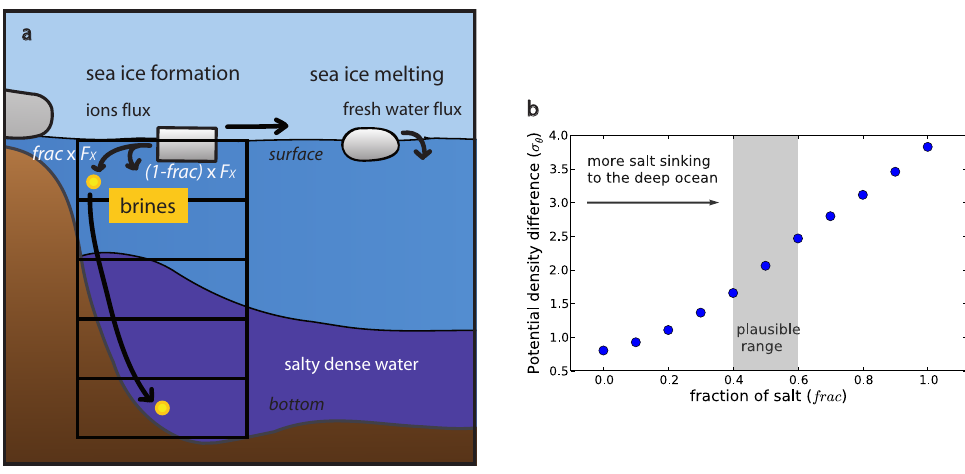
Fig. 1. (a) Brine sinking mechanism scheme and (b) Potential density difference between the deep Atlantic ocean (between − 5000m and − 3000m) and the upper Atlantic ocean (between − 2000m and 0m) as a function of the fraction of salt released by sea ice formation used for the brine mechanism (fraction of salt frac , 0 ≤ frac ≤ 1). (a) When sea ice is formed salt and other modeled ions (and dissolved gases), such as dissolved inorganic matter (DIC), alkalinity (ALK), dissolved organic carbon (DOC), nutrients, oxygen, DI 13 C and DI 14 C are released into the surface ocean beneath as a flux ( F X which is the flux of variable X ). A fraction of this flux ( frac · F X ) is dedicated to the brine sinking mechanism and is directly transported to the deep ocean instead of being diluted in the surface cell as the rest of the flux ( ( 1 − frac ) · F X ). This mechanism both creates a link from the surface to the deep ocean and sets an efficient deep ocean stratification as the vertical density gradient increases (b).